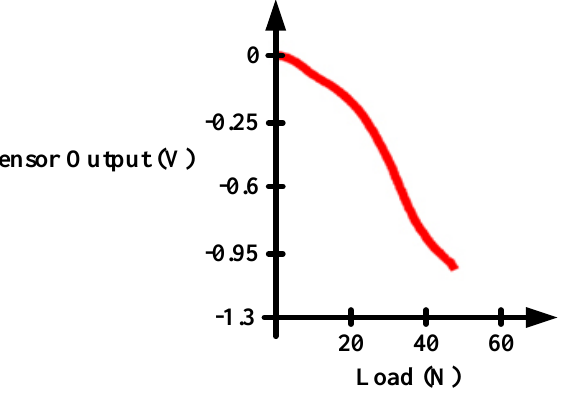
Figure 34. De Rossi et al. sensor characterization: Force vs . Output Voltage.